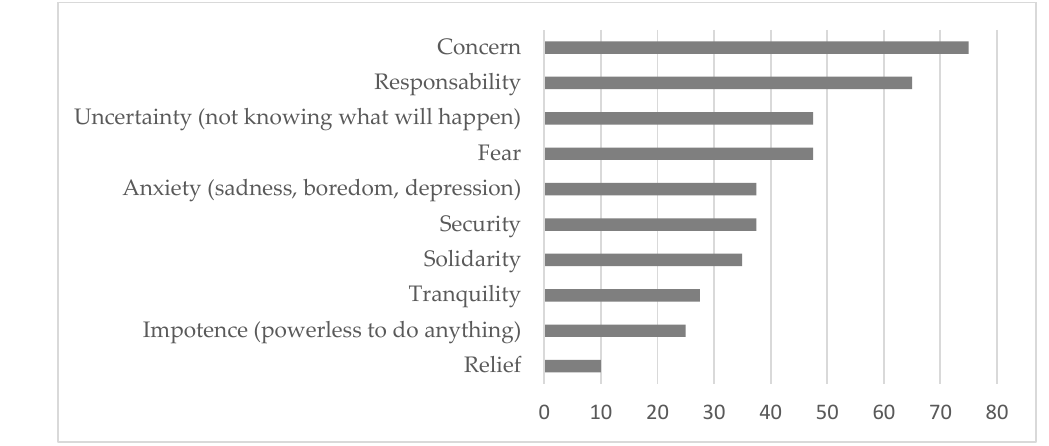
Figure 4. Percentage of people with AD in whom the pandemic situation has generated positive and negative feelings.